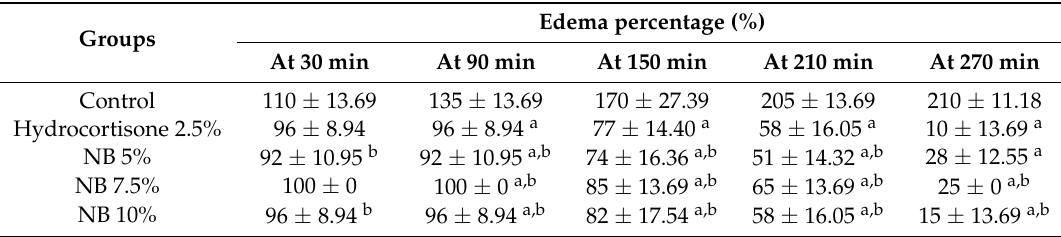
Table 2. Oedema percentage of Carrageenan-induced paw oedema.